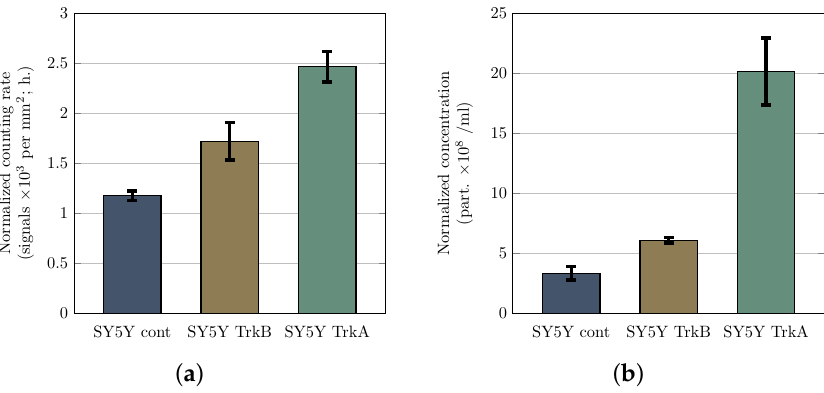
Figure 4. Comparison of samples containing microvesicles derived from non-transfected SH-SY5Y cells and cells transfected and expressing either TrkA or TrkB. Samples were measured using the PAMONO-sensor ( a ) and LM10 device ( b ). Microvesicle concentrations were detected by the LM10 device and demonstrated the following tendency—normalized microvesicle counts were increasing from non-transfected cells (SY5Y cont.) to cells expressing TrkB (SY5Y TrkB) and were the highest by cells expressing TrkA (SY5Y TrkA). These LM10 measurements were performed at least in triplicates and served as reference measurements. The same trend was received for counting rate measurements performed with the same samples using the PAMONO-sensor. Four measurements were performed using two non-crossing sensor regions in combination with two non-crossing time intervals. Error bars represent SEMs. These results demonstrate that the PAMONO-sensor allows for comparison of relative concentrations of microvesicles using only information about signal counting rates. ( a ) PAMONO-sensor; and ( b ) LM10